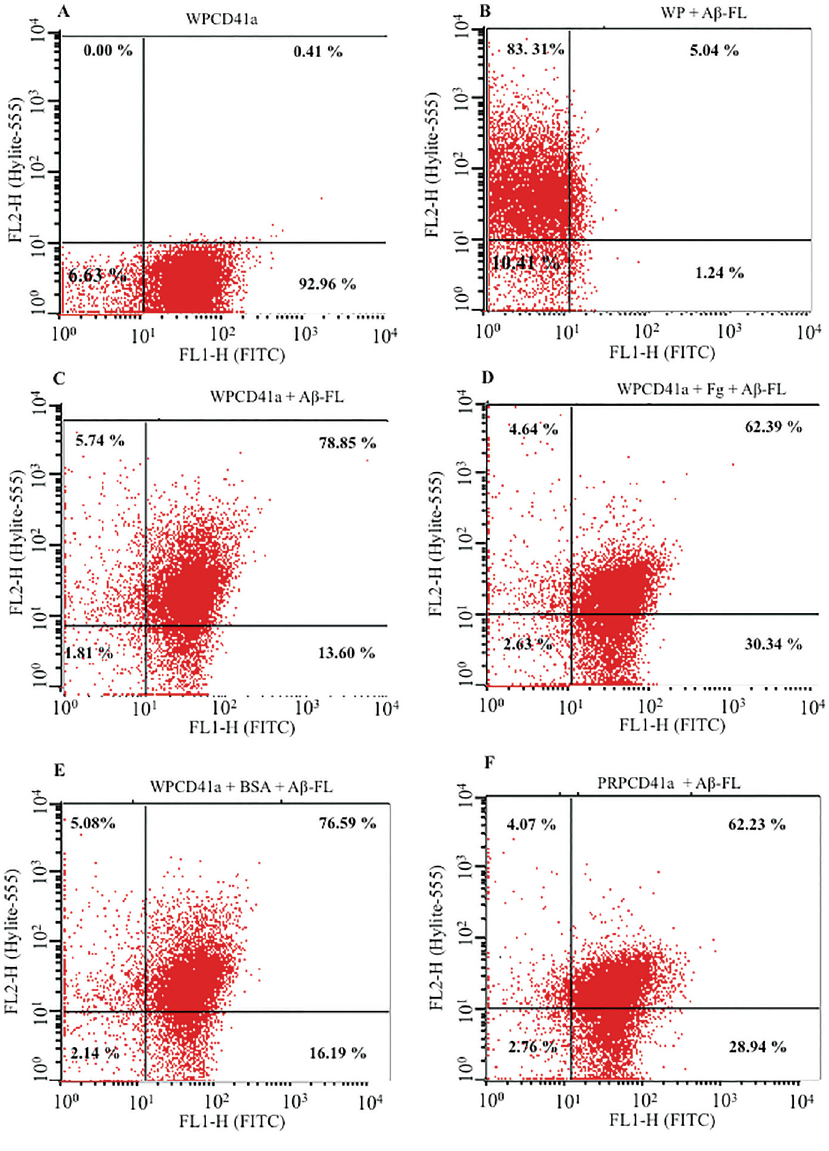
Figure 3. Interaction of fluorescently labeled A β with platelets. (A) Washed platelets labeled with CD41a-FITC (WPCD41a); (B) washed platelets treated with Hylite-555–labeled A β (A β -FL); (C) CD41a-FITC-labeled washed platelets incubated with fluorescently 42 labeled A β (A β -FL); (D) CD41a-FITC–labeled washed platelets preincubated with 42 fibrinogen (Fg; 2 mg/mL) followed by treatment with fluorescently labeled A β (A β -FL); 42 (E) CD41a-FITC–labeled washed platelets preincubated with BSA (2 mg/mL) followed by treatment with fluorescently labeled A β (A β -FL); (F) CD41a-FITC–labeled platelets 42 suspended in plasma (PRPCD41a) treated with fluorescently labeled A β (A β 42